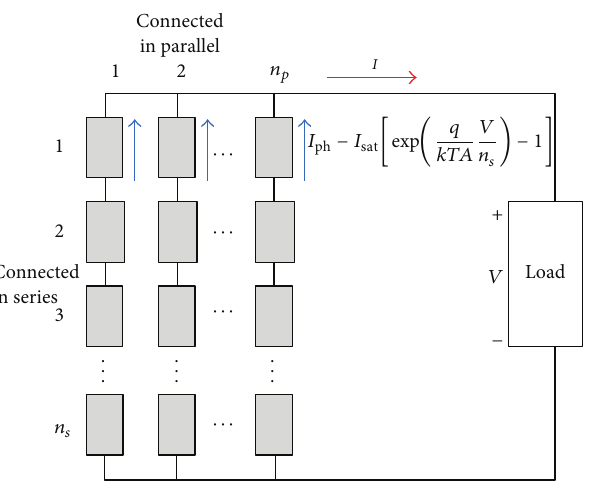
𝑃 - 𝑉 curve and 𝐼 - 𝑉 curve of photovoltaic power system.